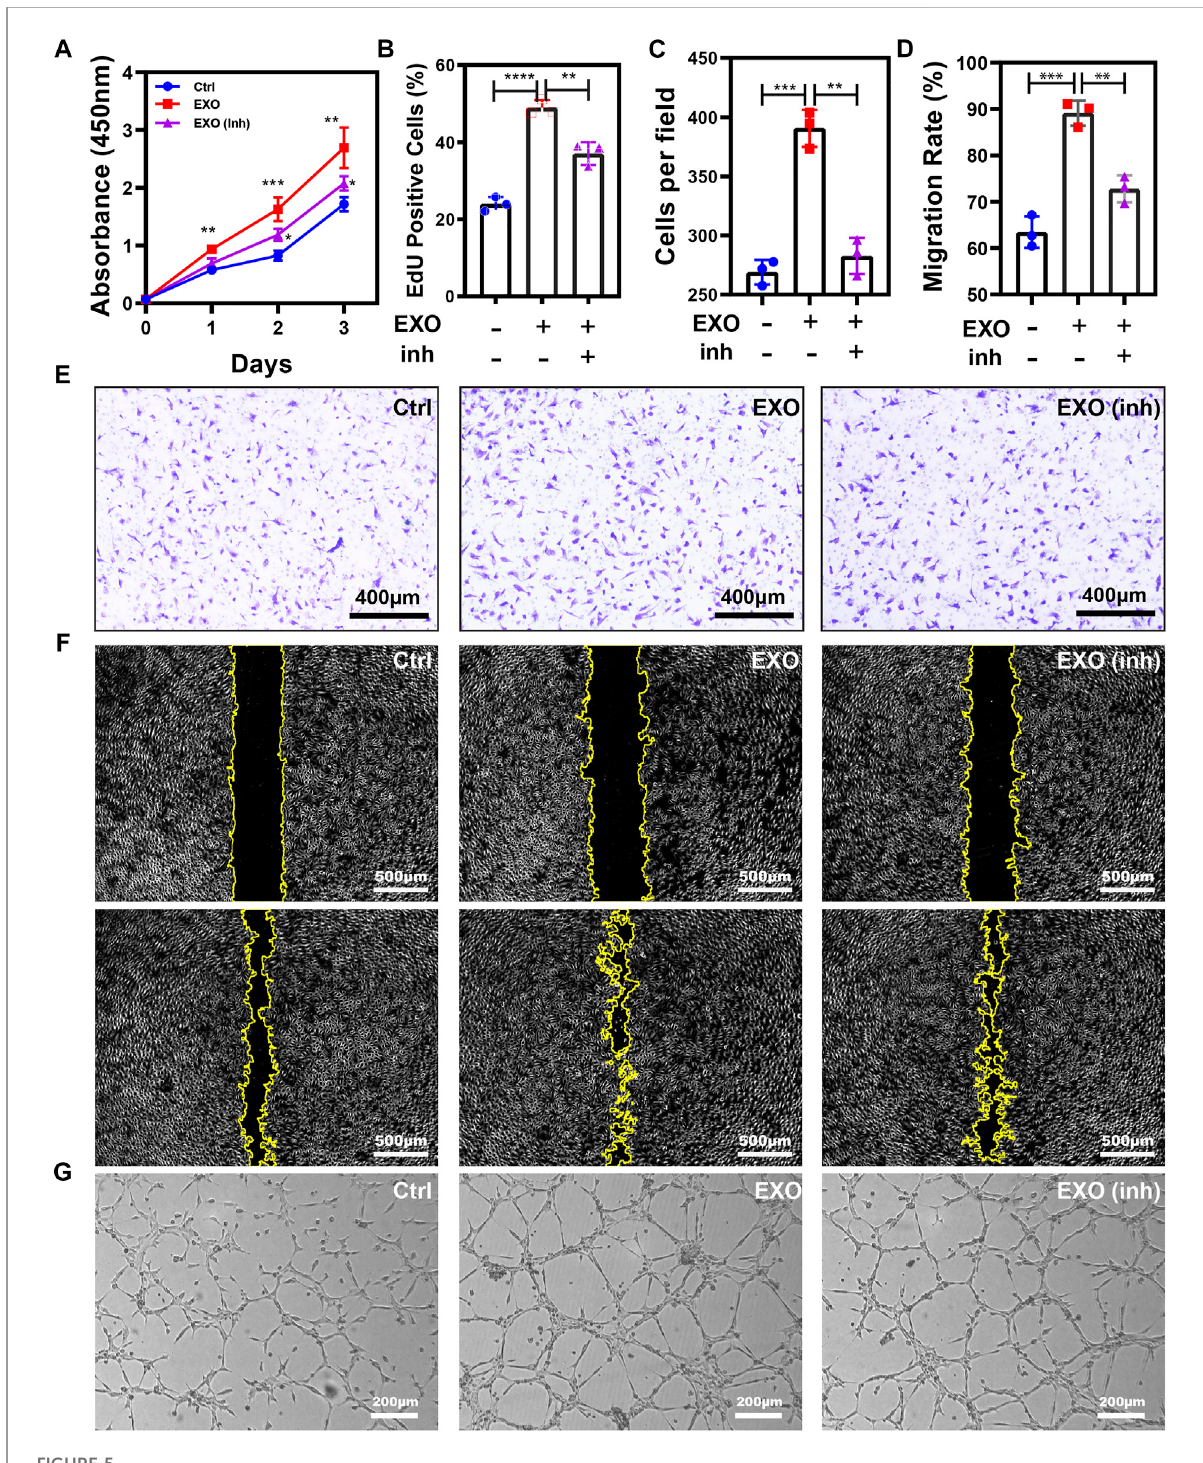
FIGURE 5 M2-EXO promotes Angiogenesis via miR-21. (A) CCK-8 assay was used to estimate HUVEC viability. The treatment of M2-EXO signi fi cantly increased absorbance at 450nm, while the co-transfection of miR-21 inhibitor counteracted this increasement. The M2-EXO + inhibitor group had slightlyhigherviabilitythanthecontrolgroup. (B) FlowcytometrywasusedtoevaluatethepercentageofEdU-positivecells.TheM2-EXOincubated grouphad ahigher EdU-positive cell count than thecontrolgroup, whiletheM2-EXO + inhibitorgroup hadasimilar EdU-positive cellcountto the control group. (C,E) Transwell assay was utilized to con fi rm the metastasis promotion role of M2-EXO treatment visually, and co-transfection of miR-21 inhibitor was used as a rescue factor to con fi rm M2-EXO works through miR-21. The average number under four fi elds was regarded